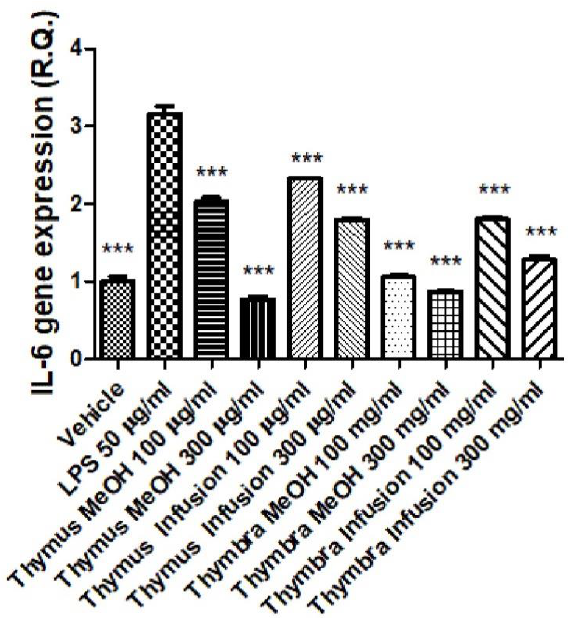
Figure 4. Inhibitory effects of Thymus sipyleus and Thymbra capitata extracts (100 – 300 µg/mL) on LPS-induced IL-6 gene expression, in isolated colon (ANOVA, p < 0.0001; *** p < 0.001 vs. LPS).